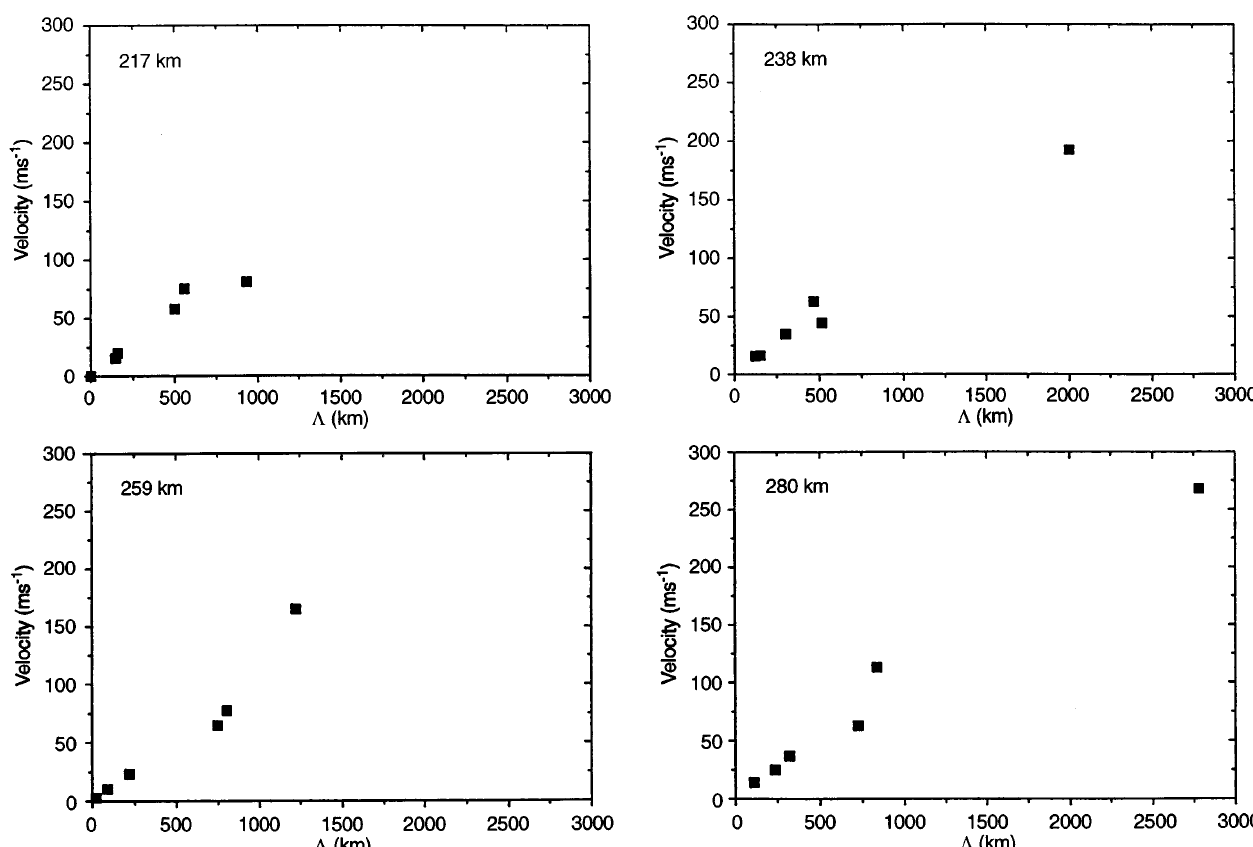
Fig. 5. V ph versus (cid:75) has been derived for the most powerful spectral components of the electron density variations for di(cid:128)erent heights. These follow the dispersion law for ionospheric wavelike processes and is evident that for longer wavelengths, the wave